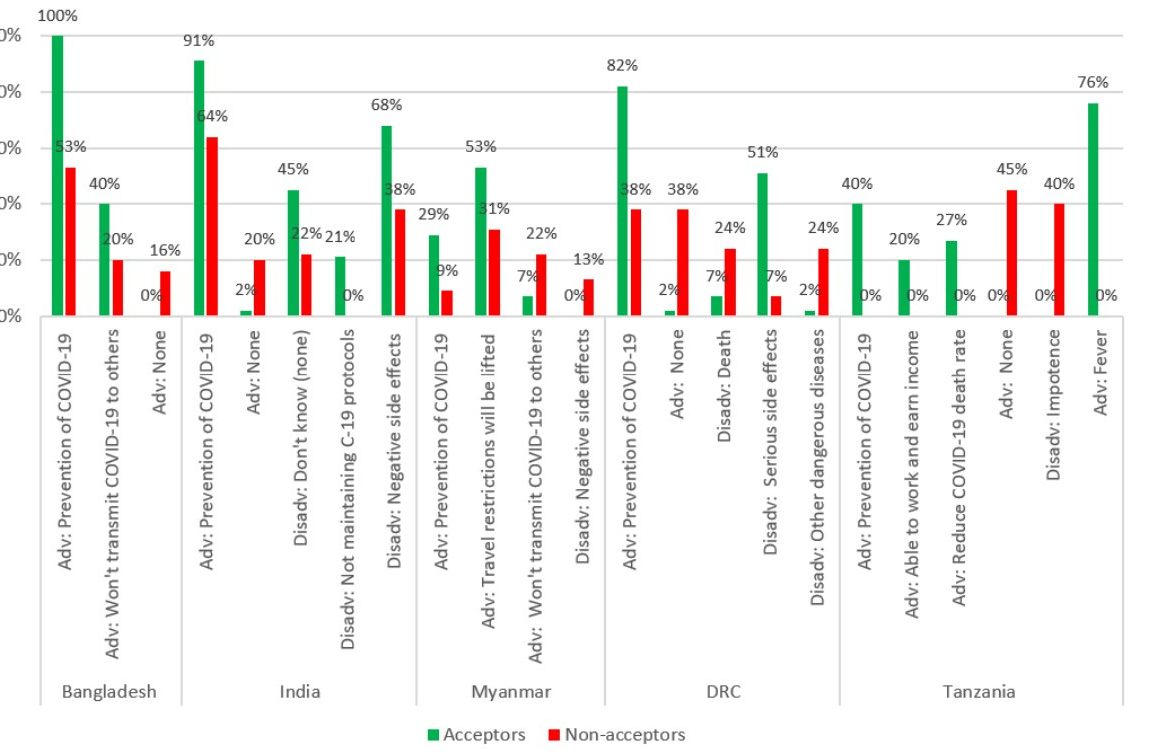
Figure 6. Perceived positive and negative consequences (advantages and disadvantages) of getting a COVID-19 vaccine by country.